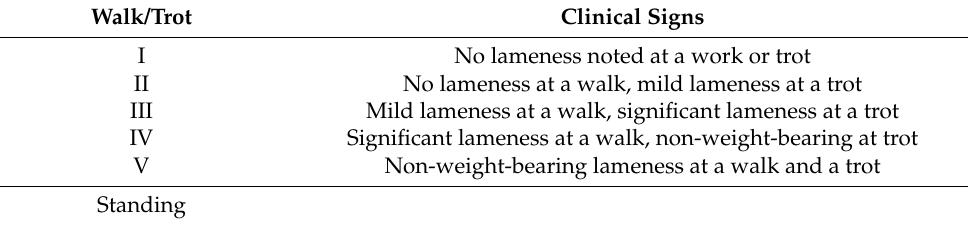
Table 2. Modified Lameness grading System.